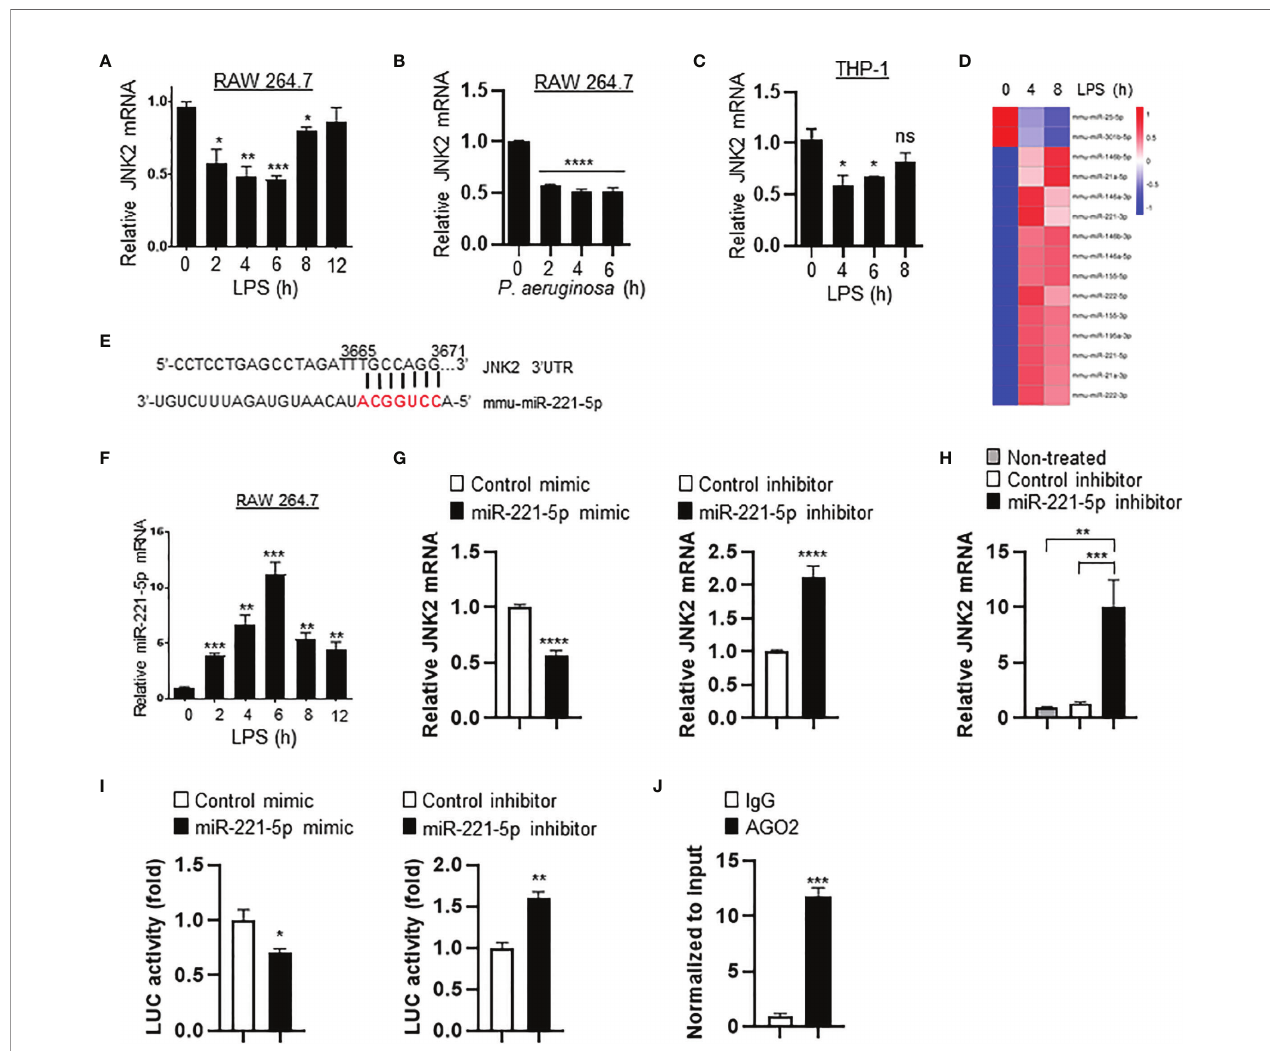
FIGURE 7 | Small RNA sequencing revealed that miR-221-5p is upregulated in response to LPS in vitro , resulting in JNK2 downregulation. mRNA expressions of JNK2 in LPS- (A) or PA103-treated (B) RAW 264.7 cells, or LPS-treated THP-1 cells (PMA-differentiated) (C) as indicated. (D) Heatmap of differential expressed miRNAs in RAW 264.7 cells treated with LPS for 0, 4, and 8h. (E) Seed sequence of miR-221-5p matching to JNK2 mRNA 3 ’ UTR. (F) Levels of miR-221-5p in RAW 264.7 cells treated with LPS for different times. (G) JNK2 mRNA levels in mouse lung epithelial cells (MLE-12) treated with mimic control or miR-221-5p mimic (left panel), or inhibitor control or miR-221-5p inhibitor (right panel). (H) JNK2 mRNA levels in whole lung homogenates of mice intratracheally treated without or with miRNA inhibitor control or miR-221-5p inhibitor. (I) JNK2 3 ’ UTR luciferase activity in the presence of miR-221-5p mimic (left panel; normalized to control mimic) or miR-221-5p inhibitor (right panel; normalized to control inhibitor). (J) JNK2 mRNA in the RNA-protein complex using Ago2 or control IgG for IP in the presence of miR-221-5p mimic (normalized to input). Data are presented as means ± sem. * p < 0.05; ** p < 0.01; *** p < 0.001; **** p < 0.0001; ns, not signi fi